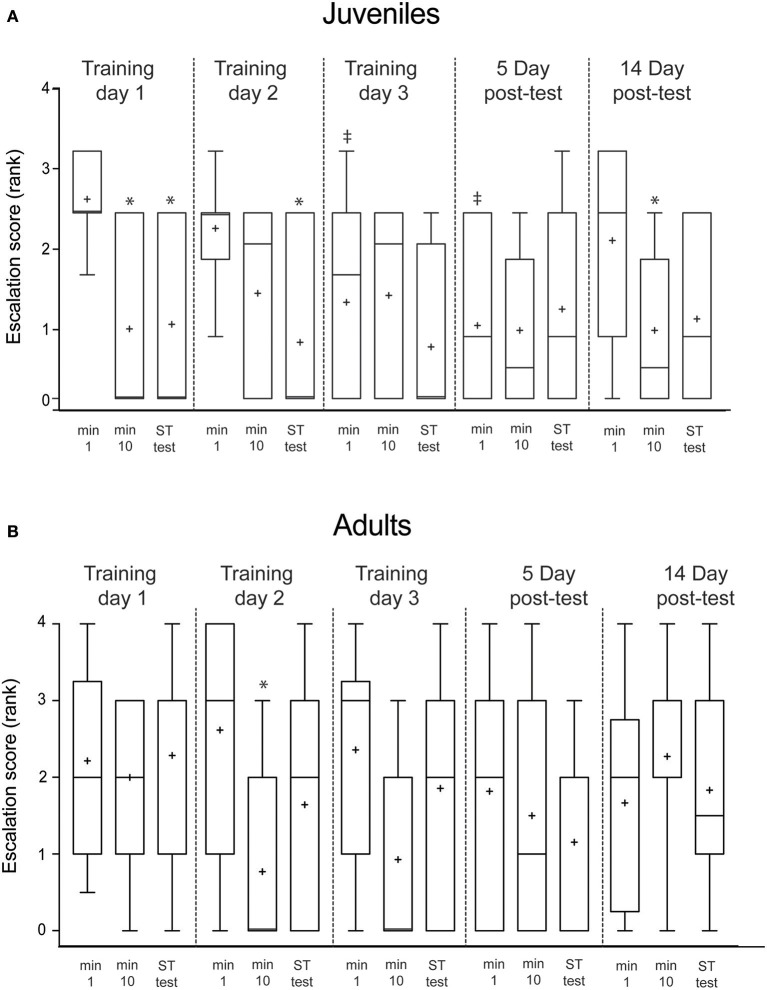
Escalation score (the highest ranked behavior produced in response to presentation of the predator mimic) declined in juveniles both within and across days, but did not decline in adults. Ranks were: no response = 0, color change = 1, avoidance swim = 2, jet = 3, arm fan = 4, ink = 5. (A) Mean escalation scores of juveniles (n = 12) plotted for the first minute, final (tenth) minute and short-term test (10 min after training) for each day of the experiment. (B) The same intervals plotted for adult squid (n = 15). Boxes show 25/75 percentiles, whiskers are 10–90th percentiles. Median is indicated with a line and mean with +. Comparisons are made with Wilcoxon signed-ranks tests. Comparisons within each day (min 1 vs. min 10 or vs. test, indicating short-term memory aquired within a trial) are denoted with *. Across trial comparisons for the first minute of Day 1 vs. first minutes on subsequent days (indicating long-term memory) are denoted with ‡.